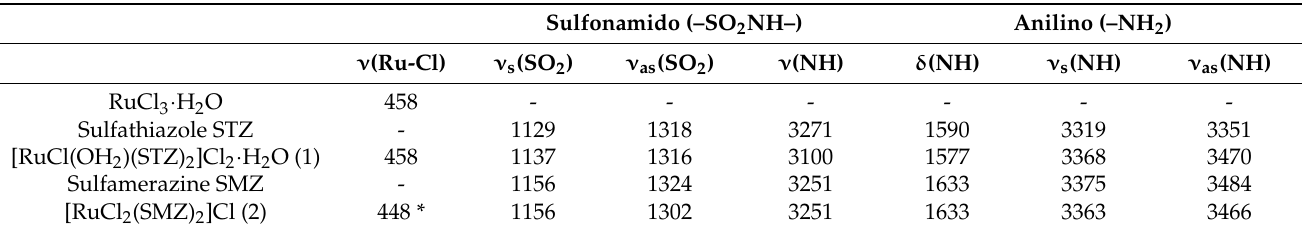
Table 1. Selected ATR spectral data of substrates and synthesized Ru(III) coordination products together with the signal assignments indicate the donor atoms of sulfonamides involved in binding the ionic metallocenter. All values of table are in [cm − 1